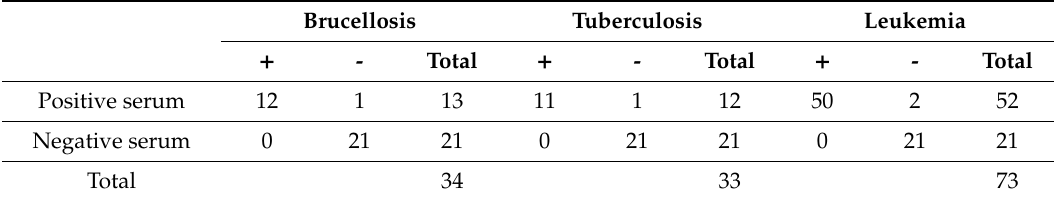
Table 2. Results of immunochromatographic testing of bovine sera.